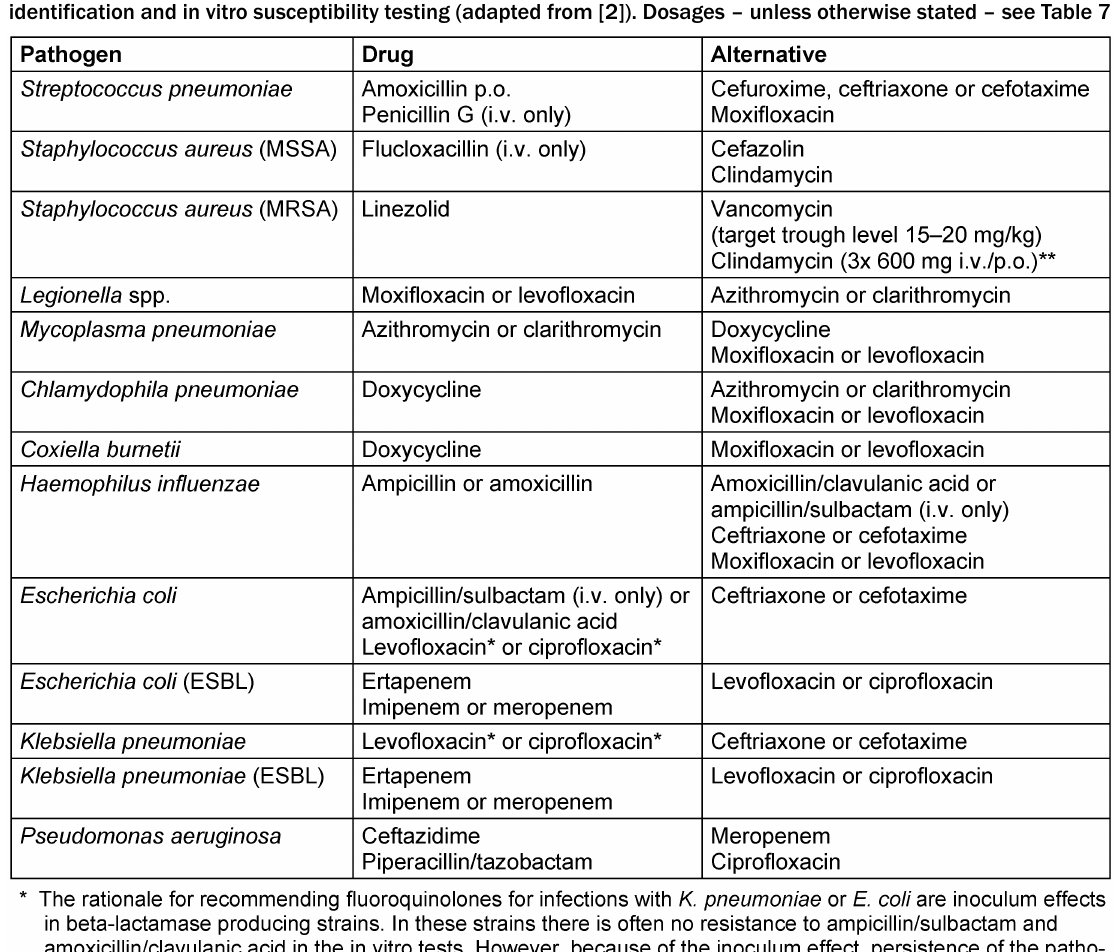
Table 6: Selected options for targeted antimicrobial treatment of patients with community-acquired pneumonia after